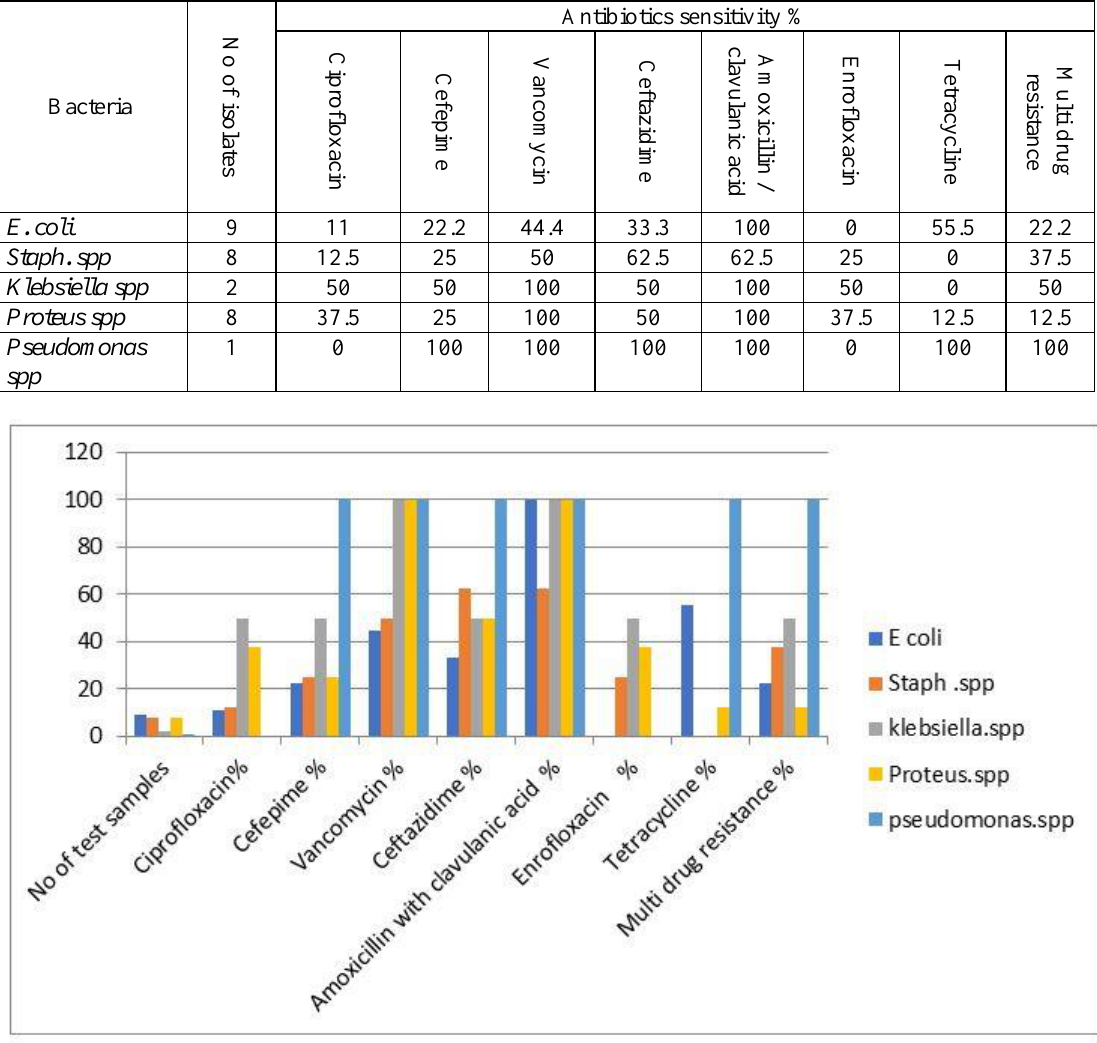
Fig. 1: Showing resistance prevalence of antibiotics toward each bacterial